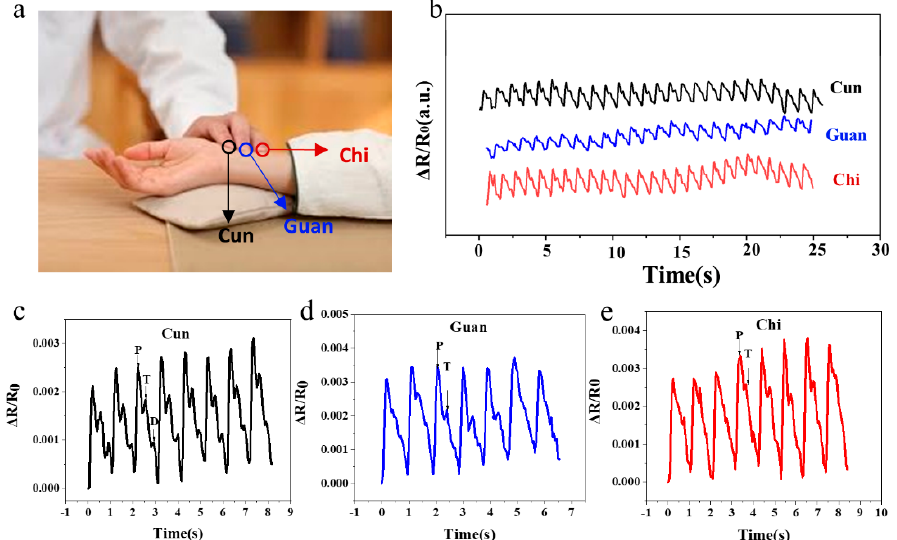
Figure 7. PVA-HEDP hydrogel sensor for pulse detection. ( a ) A photo of TCM pulse diagnosis, ( b ) Cun, Guan and Chi pulse waveforms of a 25-year-old male subject, ( c − e ) Measured typical pulse waveforms at the ( c ) Cun, ( d ) Guan, ( e ) Chi positions respectively.